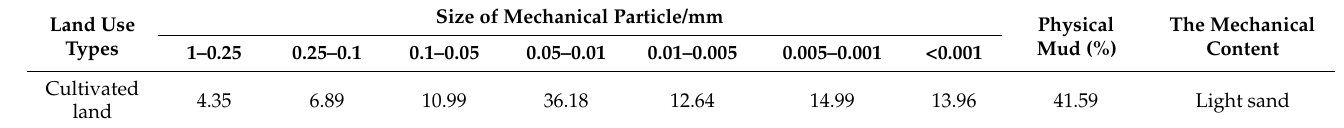
Table 7. The mechanical composition of irrigated soil in the Kibray district.